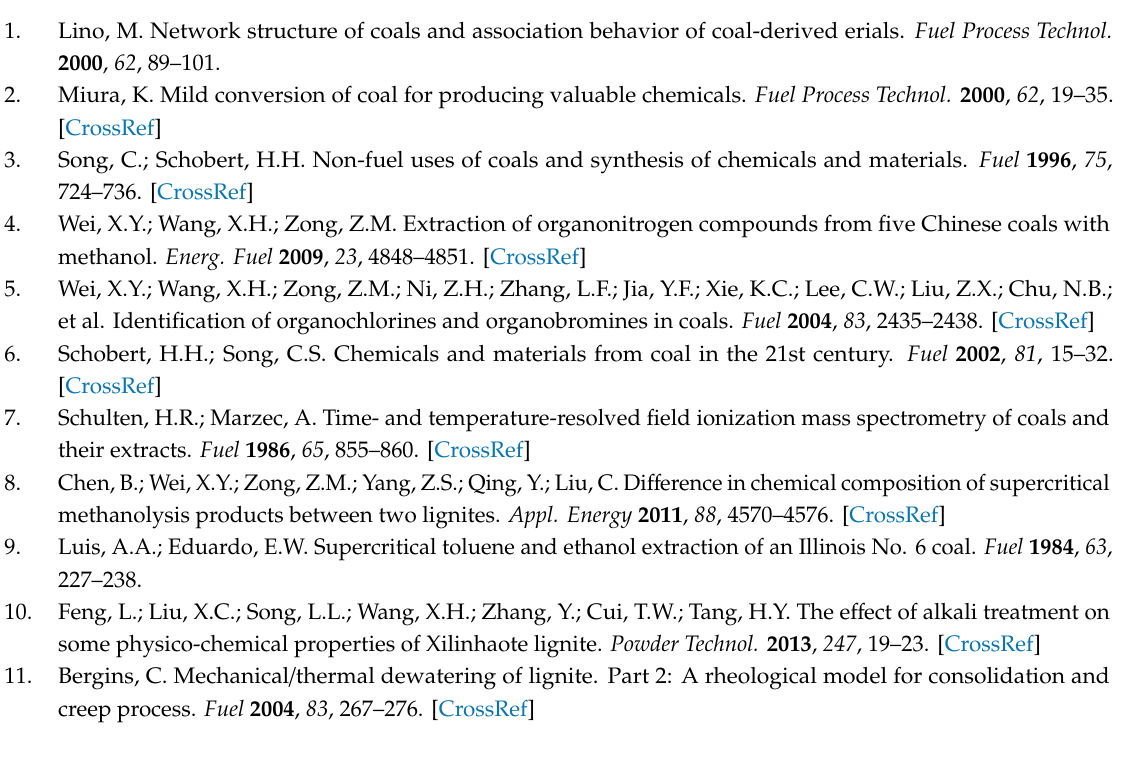
Table S1: Compounds identified by GC-MS for the extract obtained by the SE method, Table S2: Compounds identified by GC-MS for the extract obtained by the UAE method, Table S3: Compounds identified by GC-MS for the extract obtained by the MAE